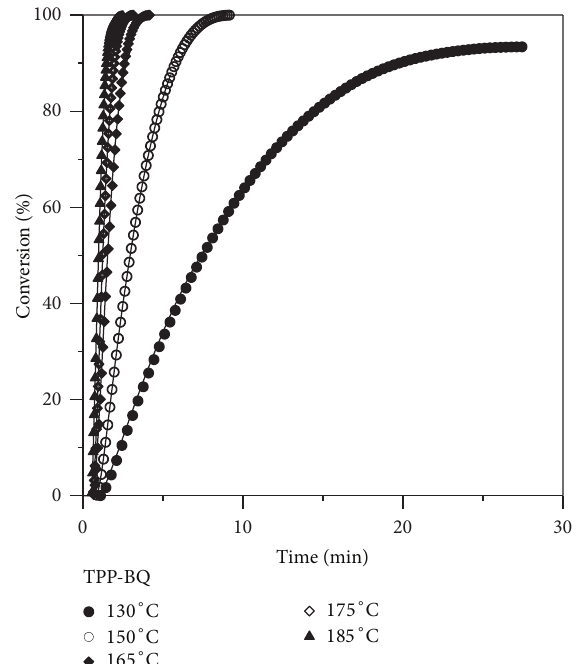
Figure 5: Comparison between the autocatalytic model and data for TPP-BQ-cured EMCs at isothermal temperatures.